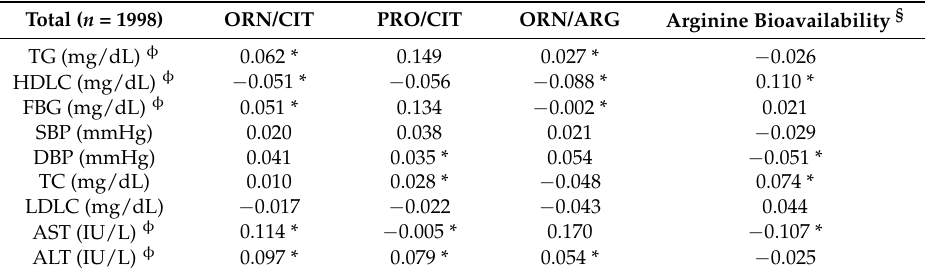
Table 2. Correlation between circulating amino acid metabolites, MetS risk factors, and related biochemical parameters.